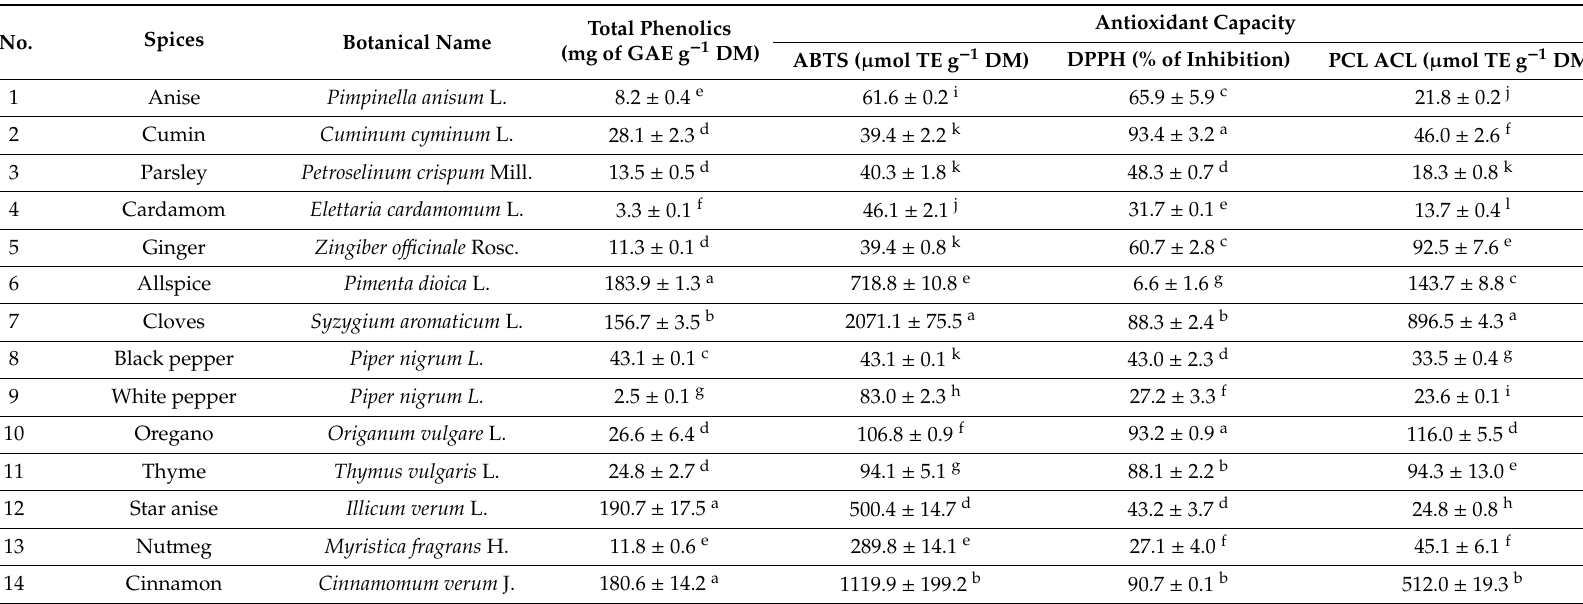
Values are means ± standard deviation ( n = 3). Values in each column with di ff erent small superscript letters are significantly di ff erent ( p < 0.05). GAE: Gallic Acid Equivalent; DM: dry matter; ABTS: 2,2’-azino-bis(3-ethylbenzothiazoline-6-sulphonic acid); DPPH: 2,2-diphenyl-1-picrylhydrazyl; PCL ACL: antioxidative capacity of lipid-soluble (ACL) compounds measured by photochemiluminescence assay TE: Trolox